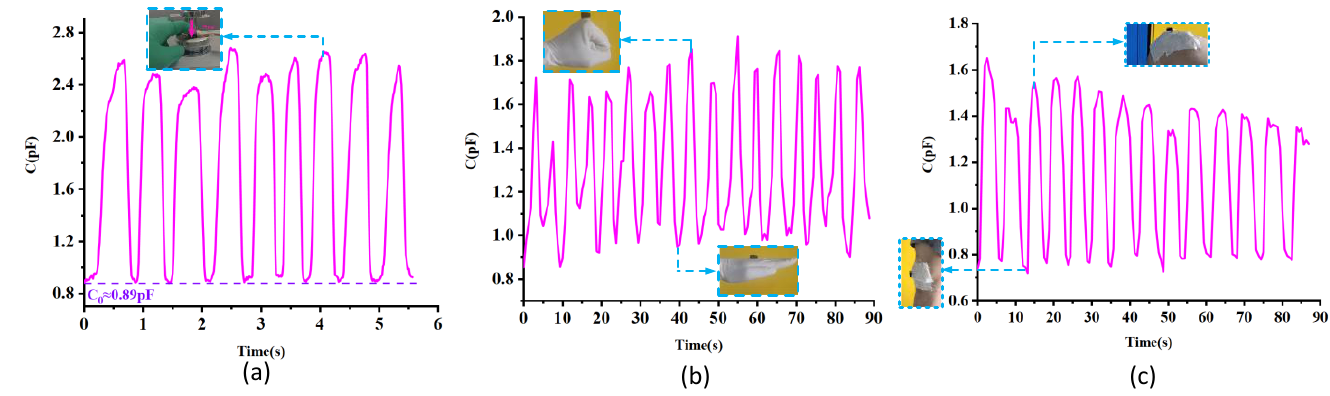
Figure 6. The application of the sensor: ( a ) the testing results of the finger pressing. ( b ) The testing results of the finger joint. ( c ) The testing results of the knee joint.